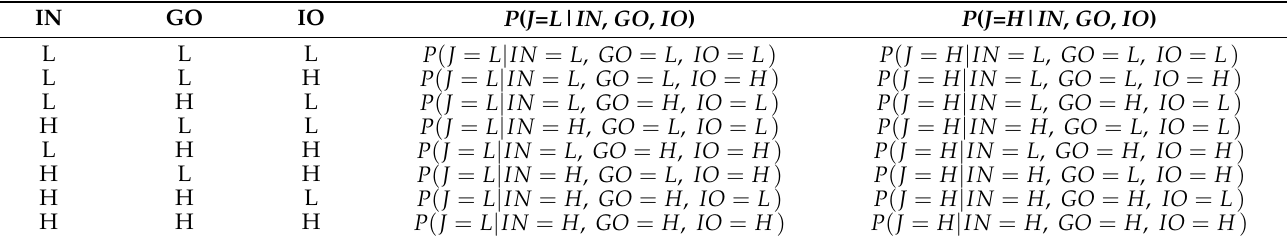
In Table 15. the layer of decision makers: I = individuals, governments, and international organizations, and in its higher layer criteria: success rate (SR), economic (Ec), environmental (En), social (So). Table 16. Conditional probability table for factors (geo-based